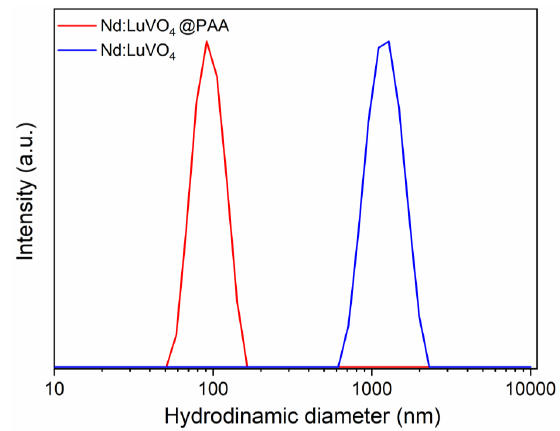
Figure 8. DLS curves obtained for the Nd (1.5%):LuVO 4 nanoparticles before and after surface functionalization with polyacrylic acid (PAA) and dispersed in 50 mM MES solution at pH = 6.5. The hydrodynamic diameter (d h ) is also included. Nanomaterials 2020 , 10 , x FOR PEER REVIEW